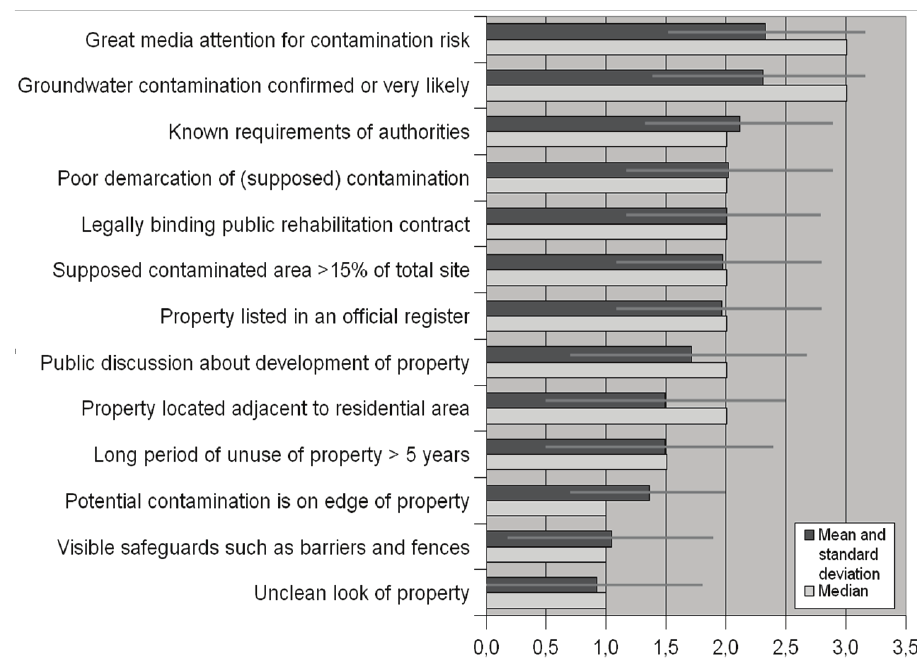
figure 4. Different weights for local characteristics equalling medians of expert